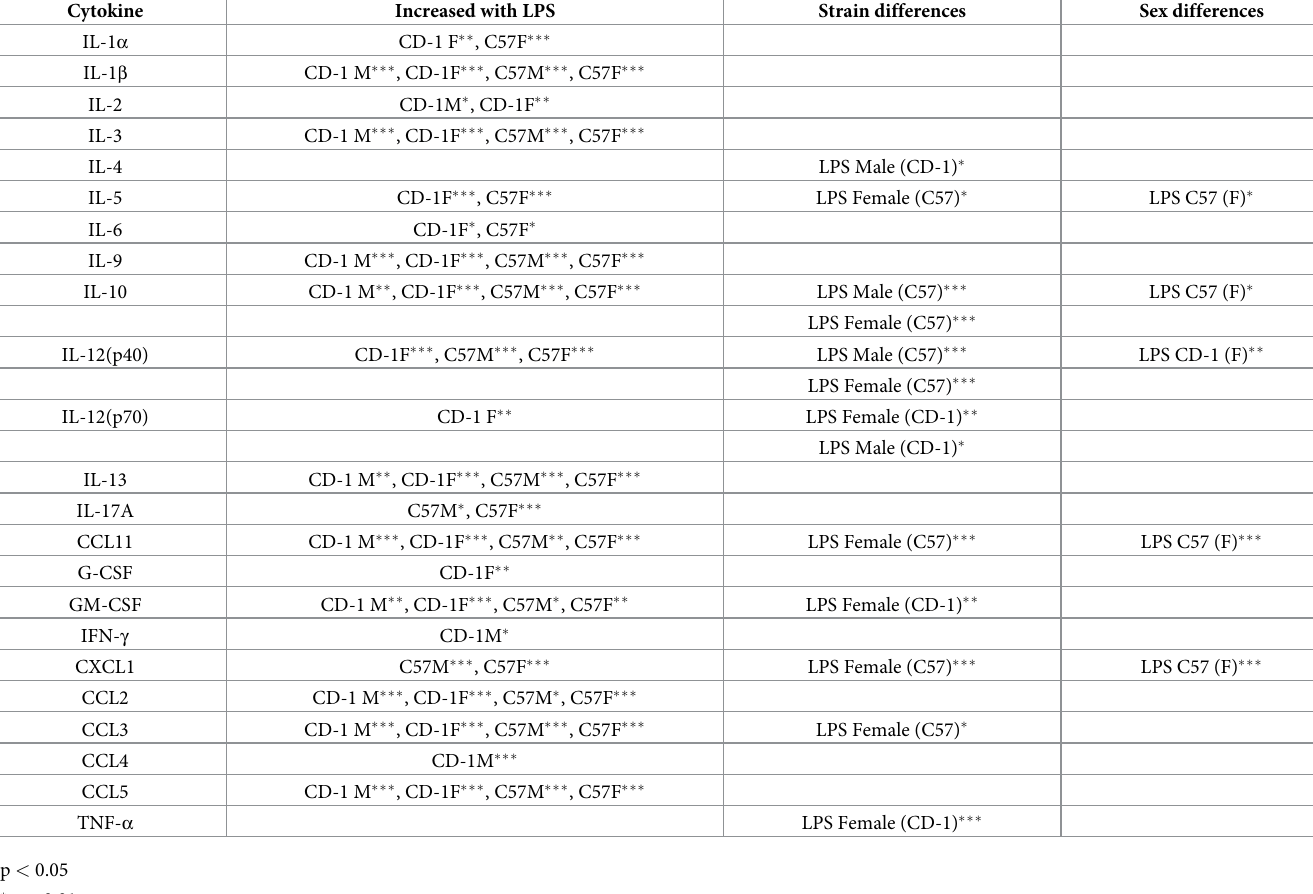
Table 4. Significant changes in serum cytokines according to sex and strain following LPS